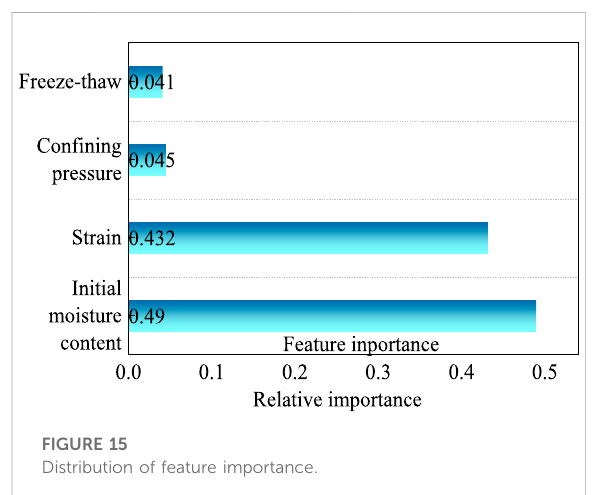
FIGURE 15 Distribution of feature importance.